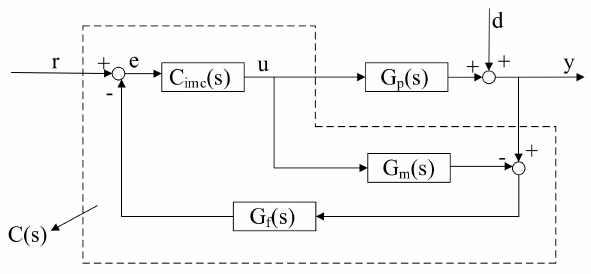
Figure 4. The block diagram of the IMC structure.